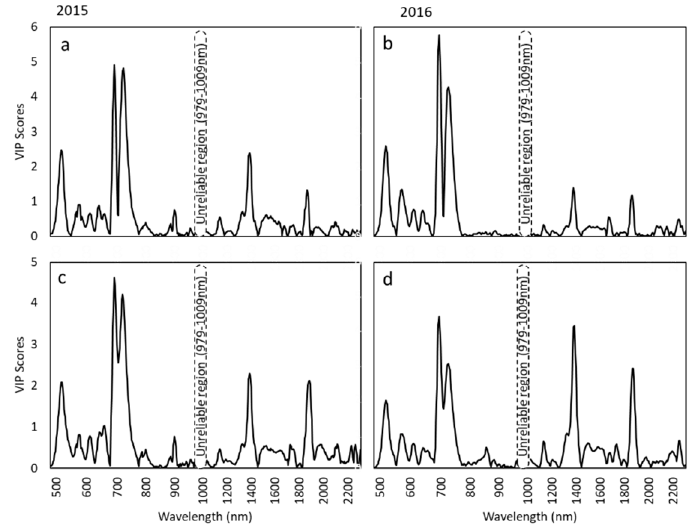
Figure 3. Variable importance in projection (VIP) plot of PLS-DA indicating the wavelength influencing the variation among the provenances ( a ) Axis 1 2015 and ( b ) Axis 1 2016 and ( c ) Axis 2 2015 and ( d ) Axis 2 2016. Variable importance in projection (VIP) values > 0.1 indicate importance in the model.